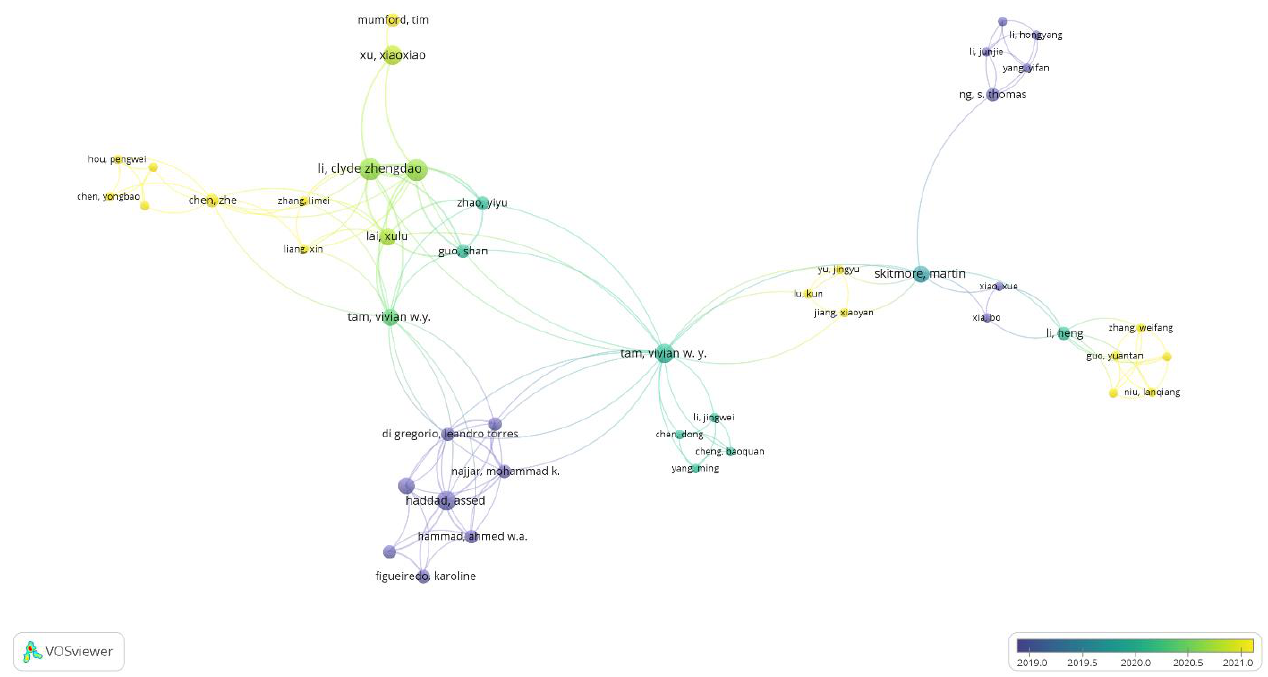
Figure 7. Author co-citation network.